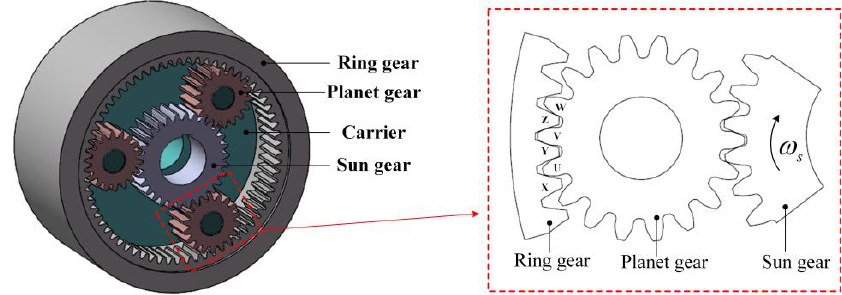
Figure 2. Structure of the planetary gearbox.